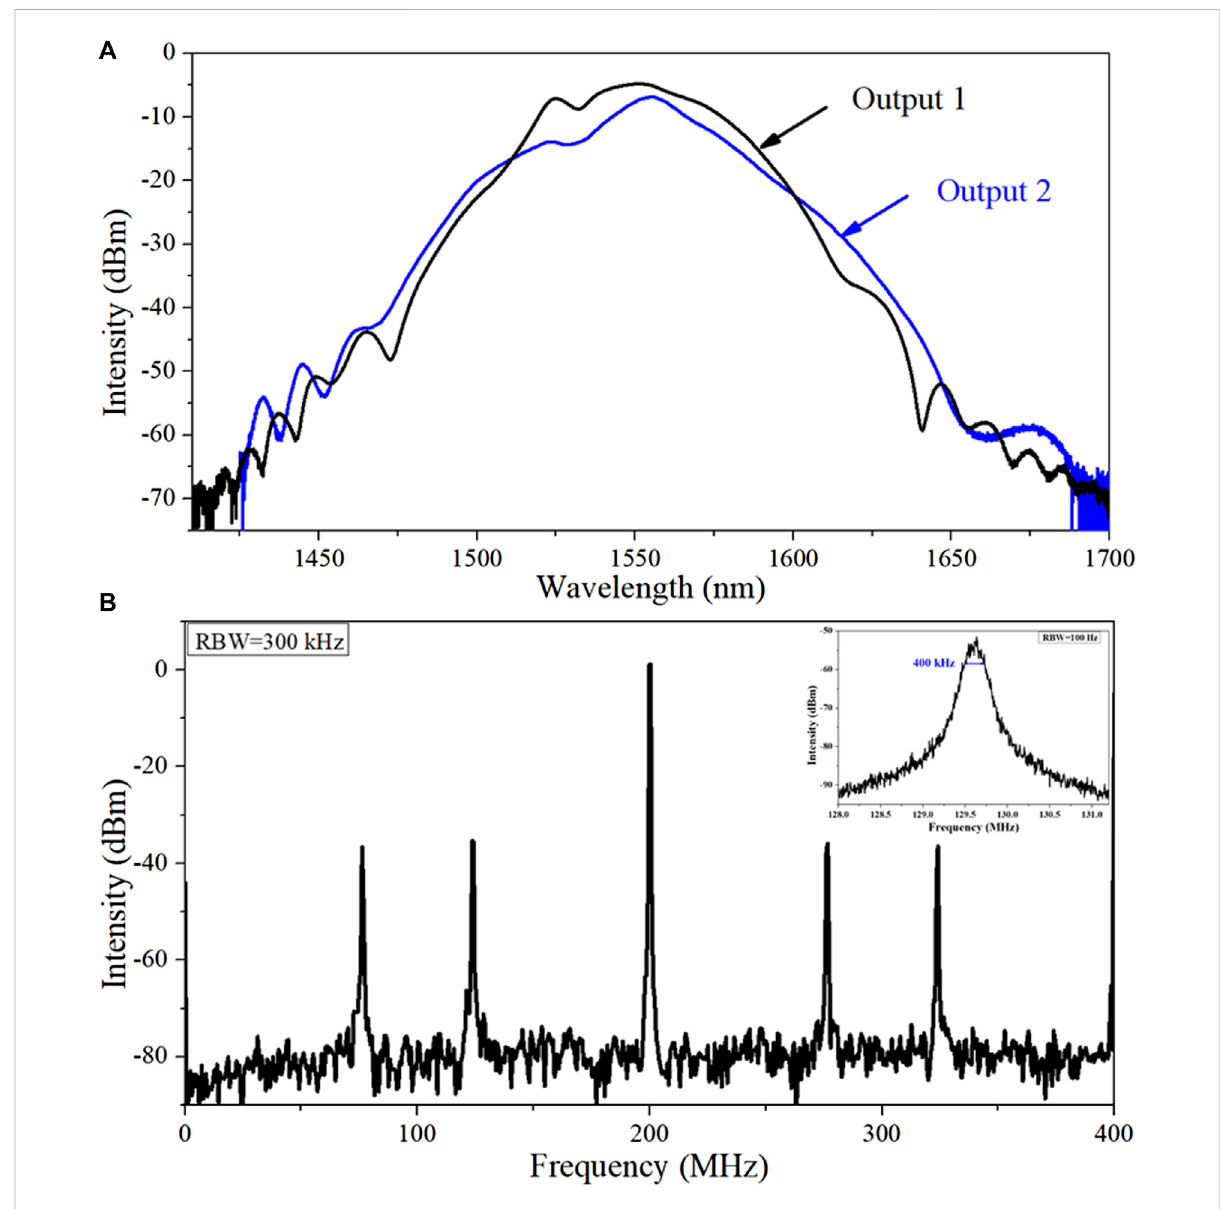
FIGURE 2 (A) Spectra of the laser outputs. (B) rf spectrum of f ceo